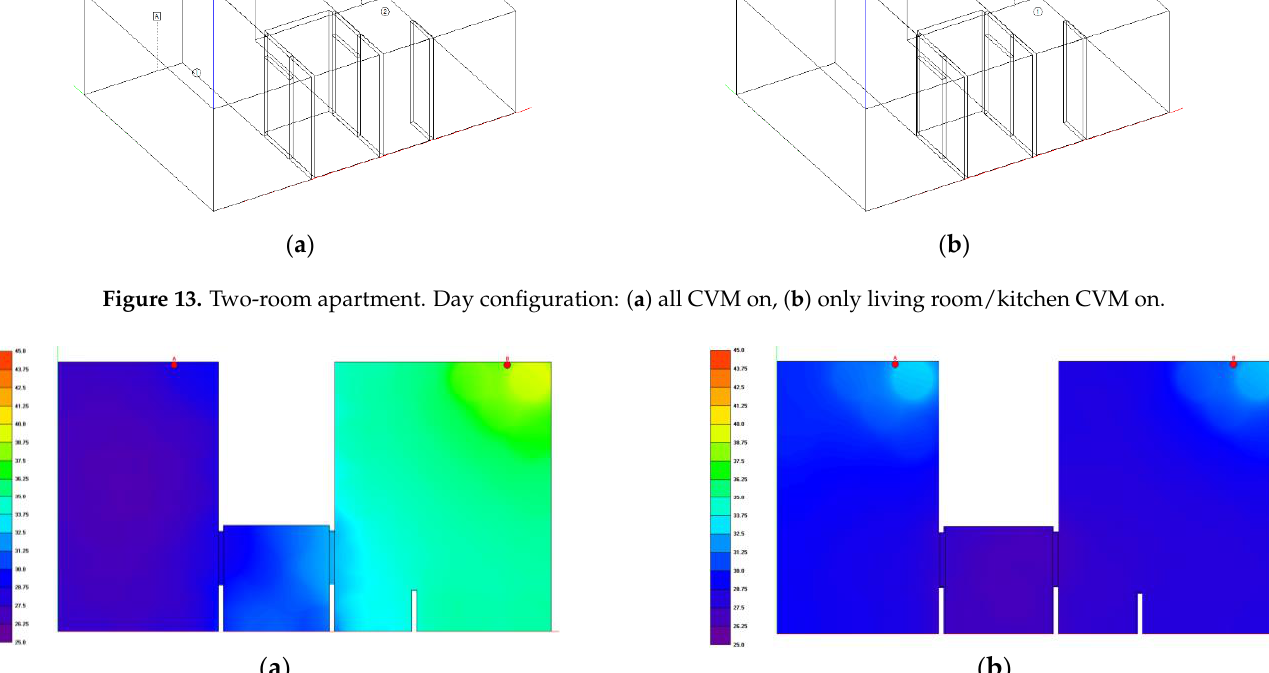
Figure 14. Two-room apartment. ( a ) “Night” configuration A-weighted sound pressure levels. ( b ) “Day” configuration A-weighted sound pressure levels.